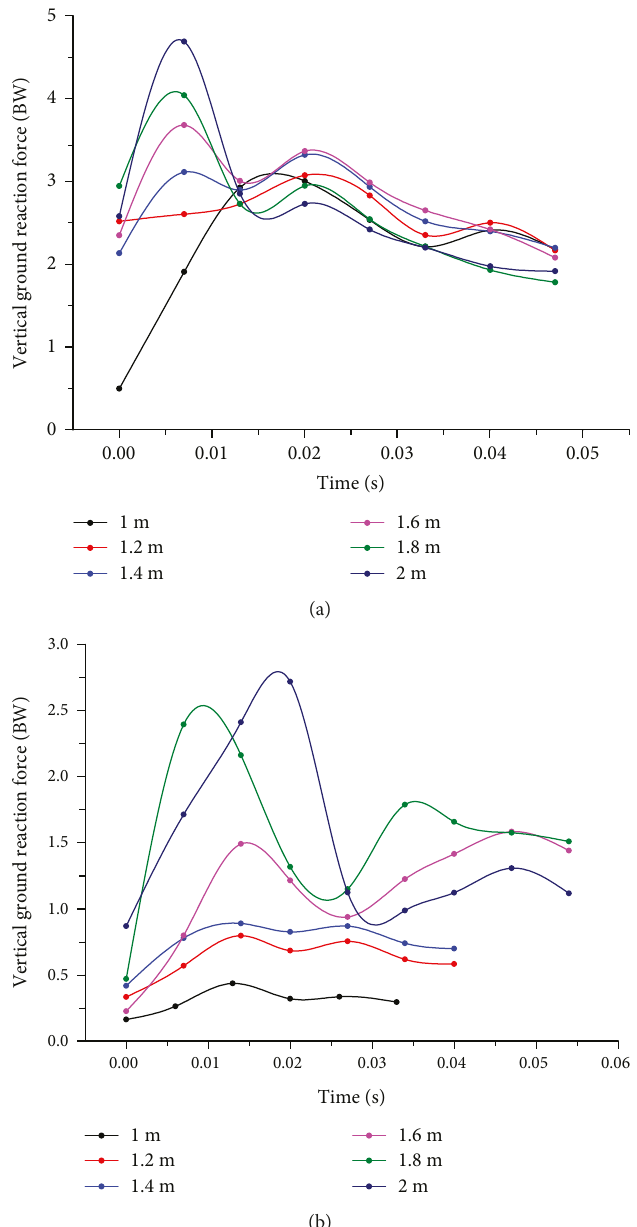
Figure 3: Representative average VGRF curves of the (a) RF and (b) RH limbs during the landing period from all jump